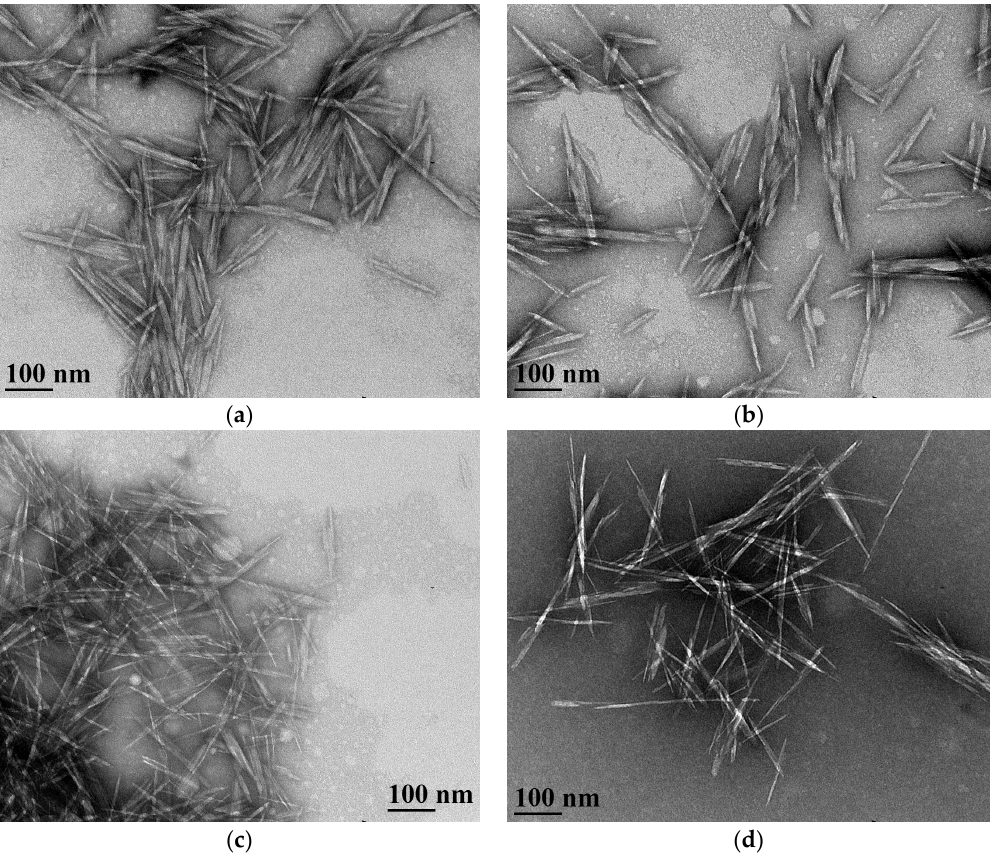
Figure 3. Transmission Electron Microscope (TEM) image of CNC isolated from: ( a ) untreated filter paper; ( b ) 8 h enzyme-treated filter paper; ( c ) untreated wood pulp and ( d ) 8 h enzyme-treated wood pulp.